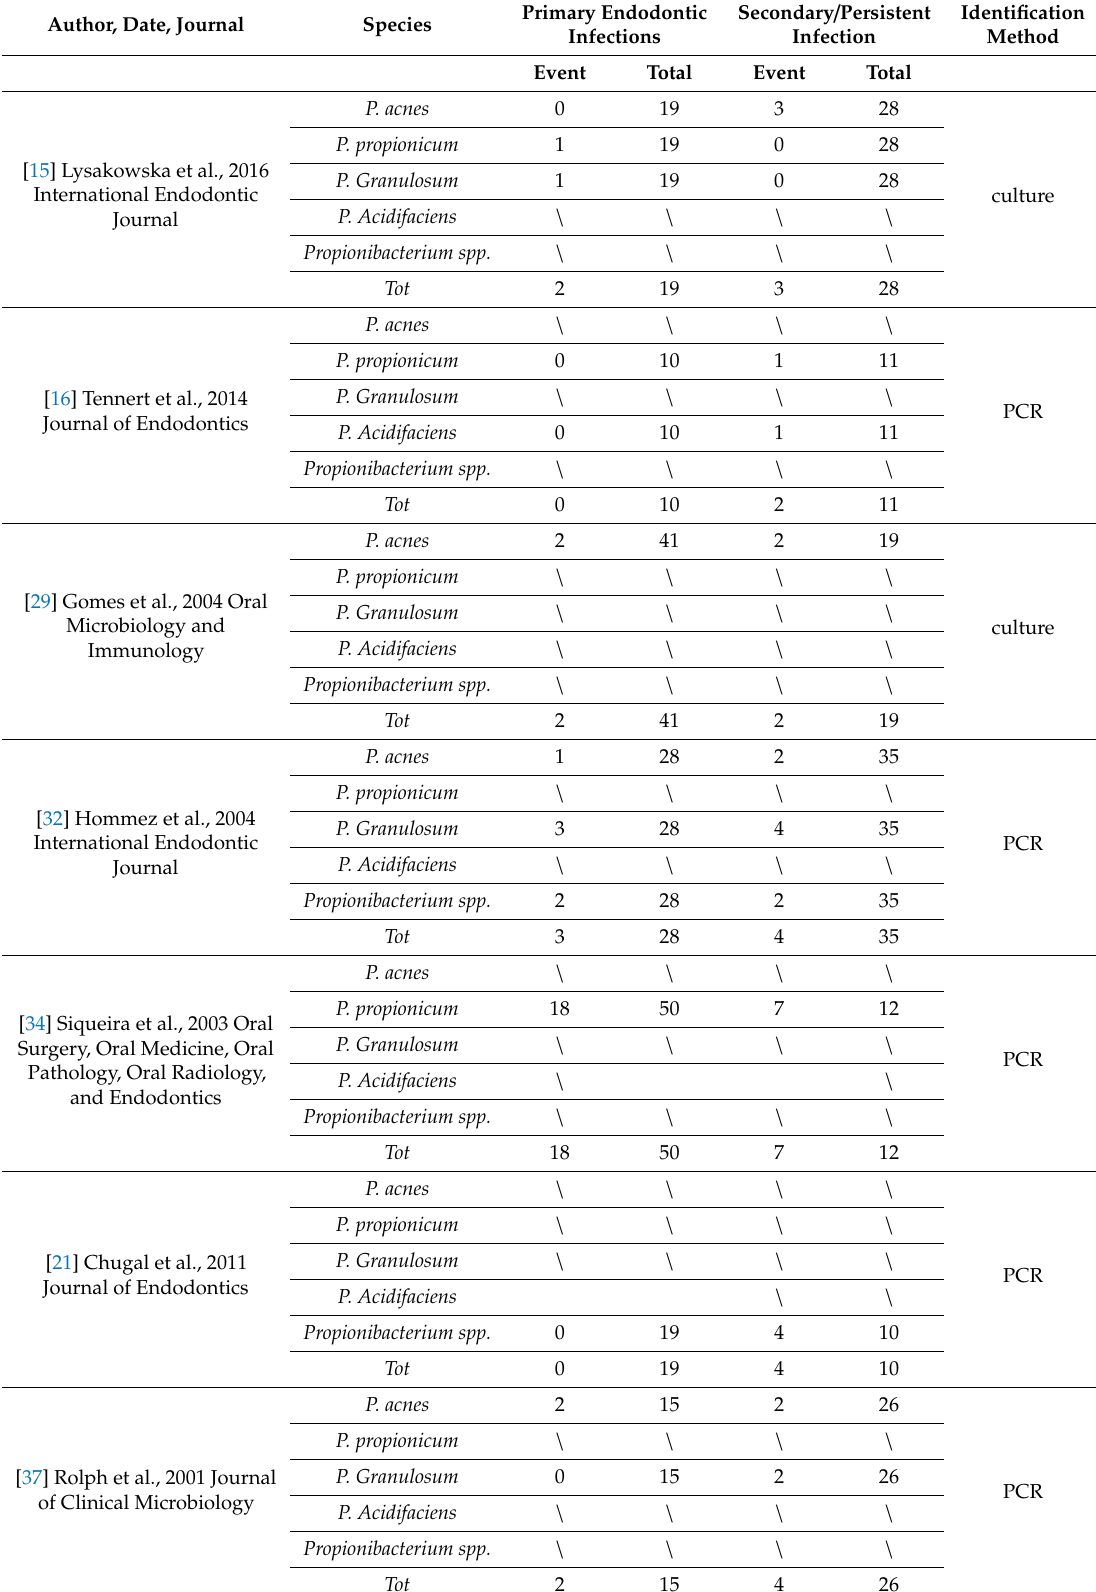
Table 4. Secondary outcome (di ff erence in the prevalence of bacteria of the genus Propionibacterium between primary endodontic infections and secondary endodontic